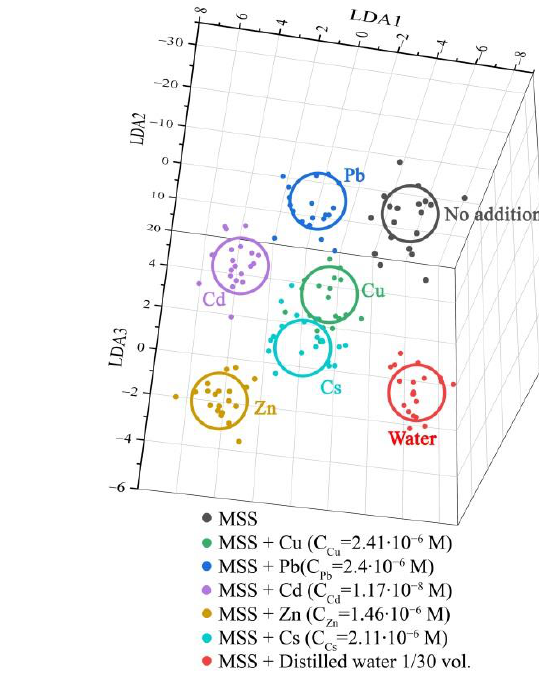
9 of 13 Figure 6. Normalized spectral responses (maxima of fluorescence intensities of three dyes upon excitation at 260 nm and at the maximum absorption of each dye) of the fluorescent probe array to various metal ions: ( a ) CuNO 3 (C Cu(NO3)2 = 2.41 × 10 − 6 M), ( b ) PbNO 3 (C Pb(NO3)2 = 2.8 × 10 −5 M), ( c ) CdNO 3 (C Cd(NO3)2 = 1.17 × 10 −8 M), ( d ) ZnNO 3 (C Zn(NO3)2 = 1.46 × 10 −6 M), ( e ) CsCl (C CsCl = 2.11 × 10 −6 M), ( f ) H 2 O. The pristine fluorescence intensities of the dyes in array are normalized to 1. For each recognition class, 20 sets of initial data were used for training by introduc- ing random errors into the initial data. According to the idea of the LDA algorithm, the projection is carried out in such a way as to ensure the maximum separation of classes regarding a scatter of data within a single class [71].